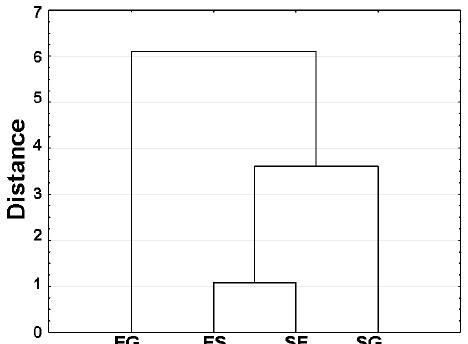
Figure 3. Dendrograms presenting multivariate similarity of the fe- male turkey genotypes (SG – slow growing; FG – commercial fast growing; reciprocal crossbreed: SF (SG sires × FG dams); FS (FG sires × SG dams)), according to the examined blood parameters: al- kaline phosphatase, alanine transaminase, aspartate transaminase, cholinesterase, creatine kinase, γ -glutamyltransferase, lactate de- hydrogenase and lipase based on cluster analysis (Ward’s method of